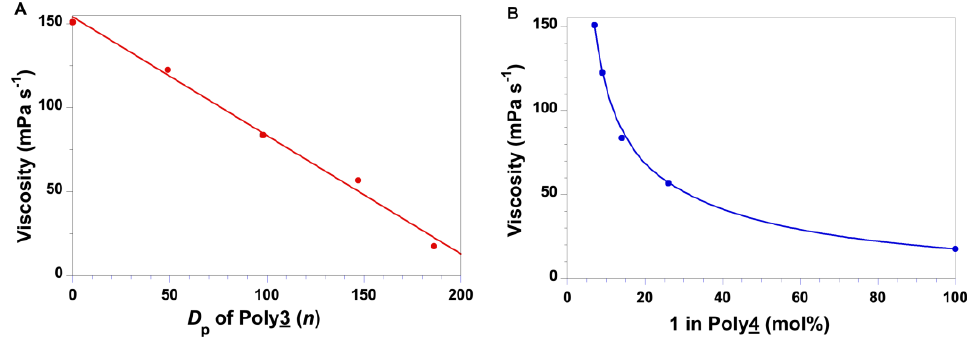
Figure 2. Relationships between the adhesive strength (MPa) and the ( A ) degree of polymerization ( D p ) of Poly 3 ( n ) and ( B ) ratio of 1 in Poly 4 (mol%). ( D p ) of Poly 3 ( n ) and ( B ) ratio of 1 in Poly 4